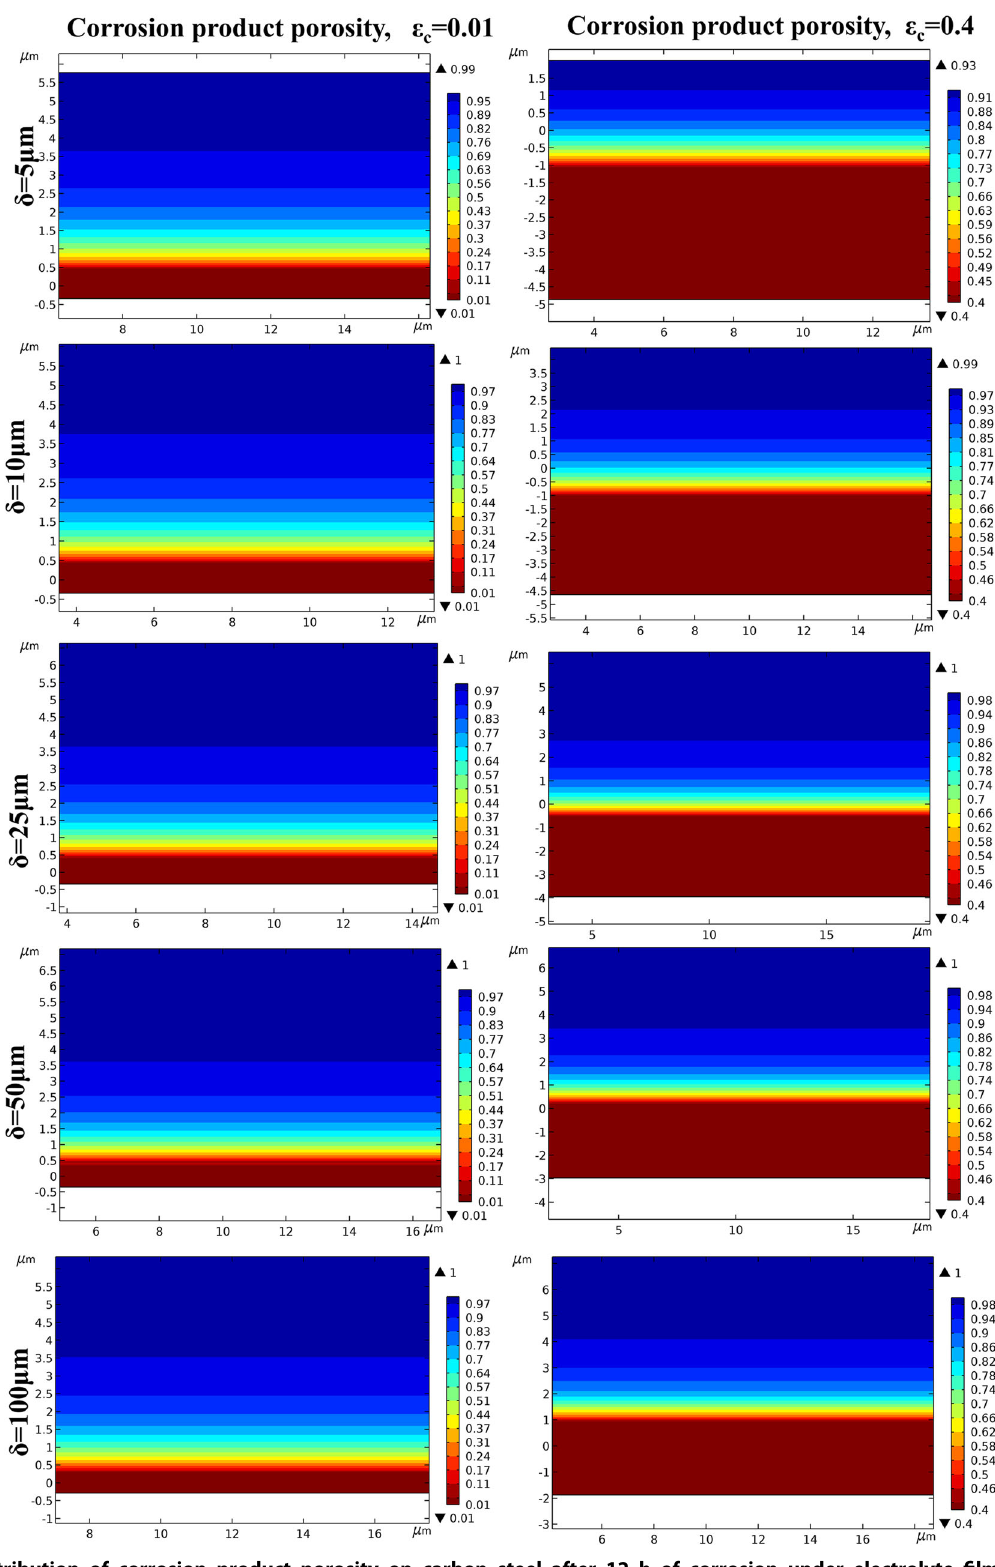
Fig. 3 The distribution of corrosion product porosity on carbon steel after 12 h of corrosion under electrolyte fi lm with different thicknesses. Left: the ε of corrosion products is 0.01. Right: the ε of corrosion products is 0.4.